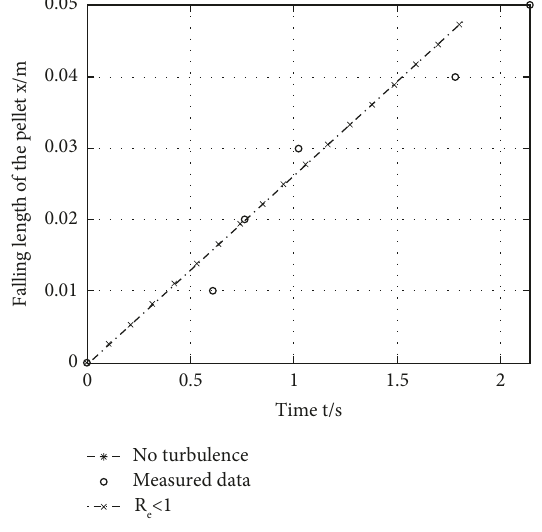
Figure 6: Displacement-time relationship of the